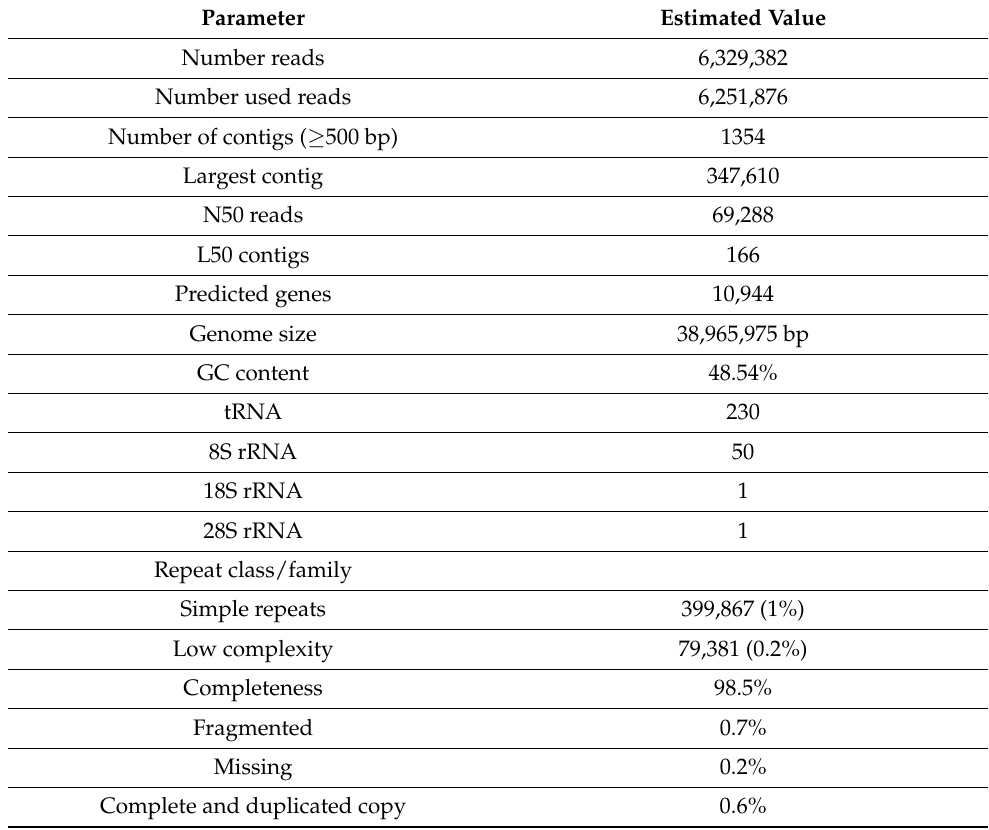
Table 1. Summary of the T. hamatum FBL 587 genome sequencing and assembly